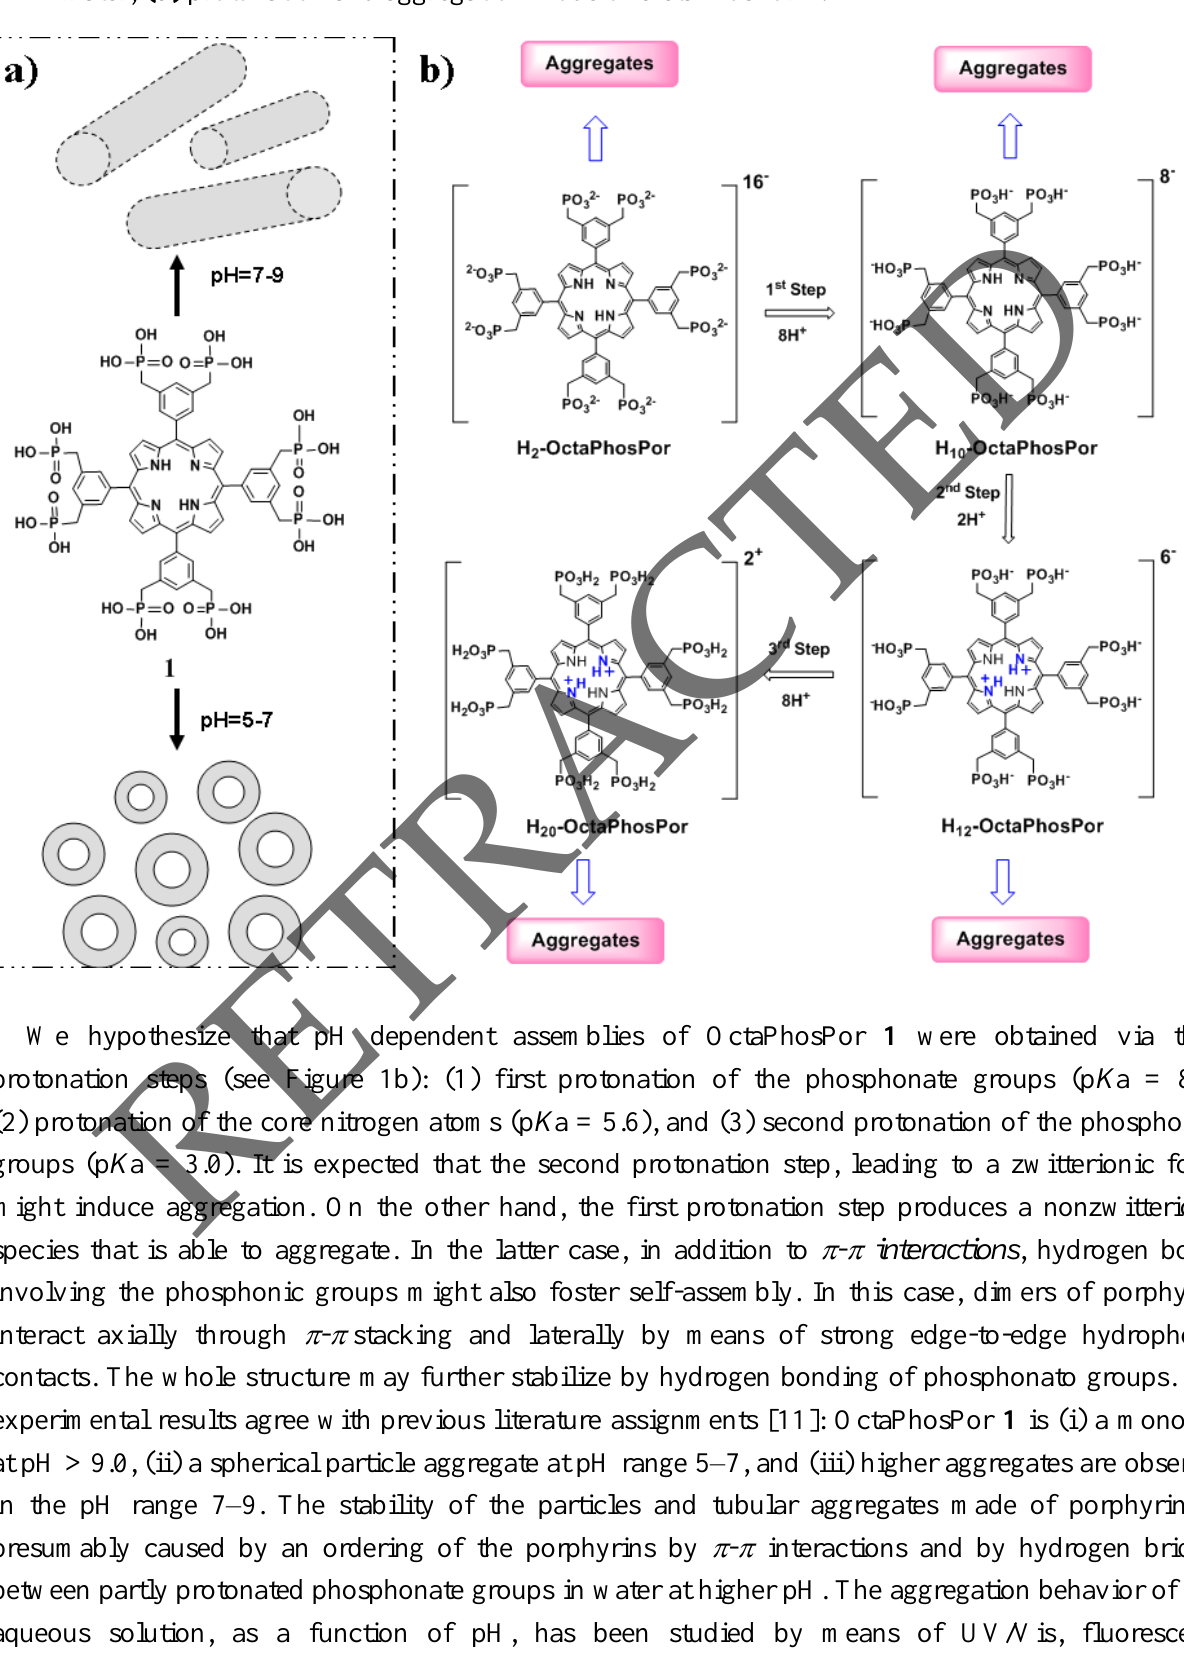
Figure 1. (a) Schematic representation of the self-assembly of the OctaPhosPor 1 into: nanosphere aggregates at pH 5–7, and further aggregation of 1 into nanorods at pH 7–9 in water; (b) protonation and aggregation mode of OctaPhosPor 1